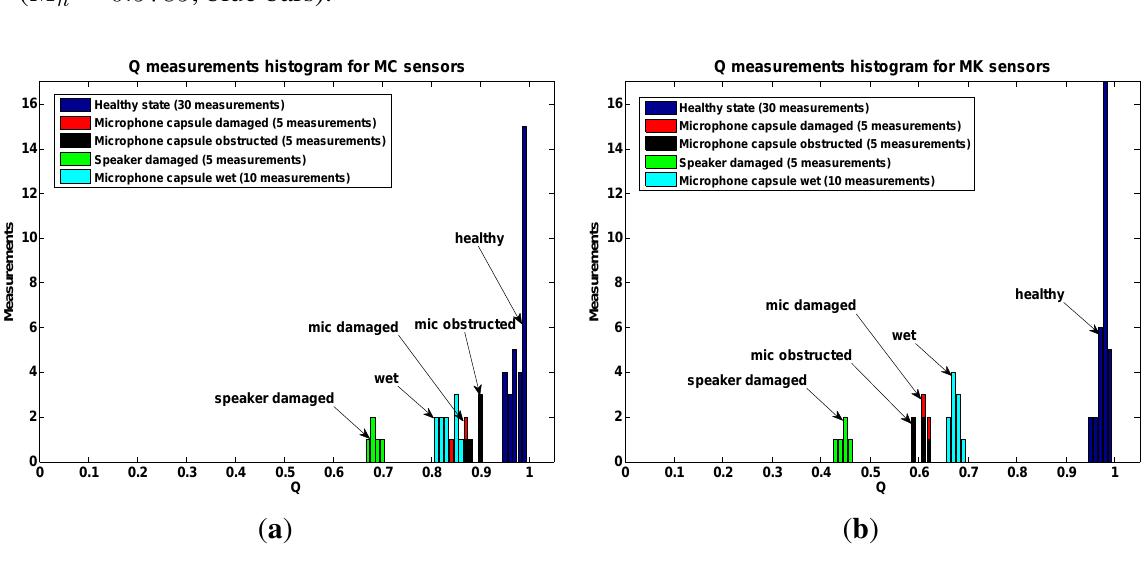
= 0 . 9844 , blue bars); ( b ) MK h